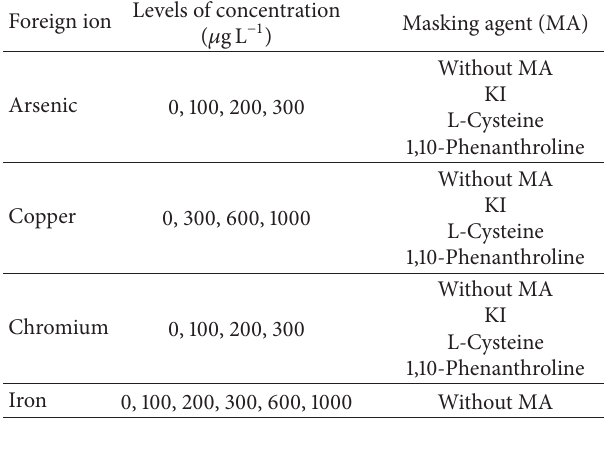
Table 2: Assays carried out for foreign ions. Levels of concentration Foreign ion ( 𝜇 gL −1 )